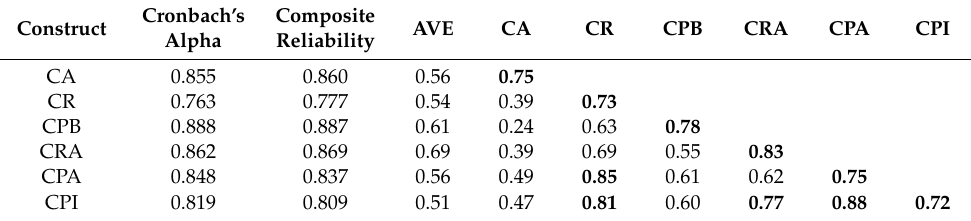
Table 2. Reliability, correlation coe ffi cients, and average variance extracted (AVE) results.